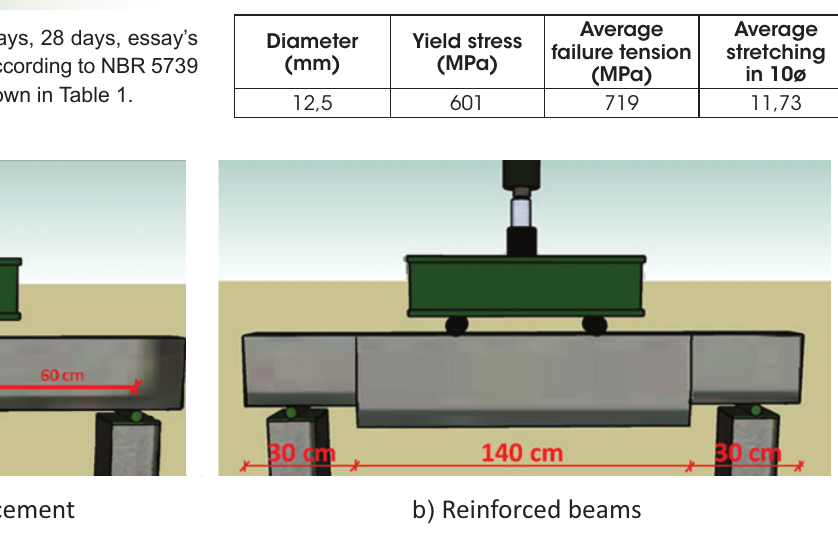
Mechanical properties of